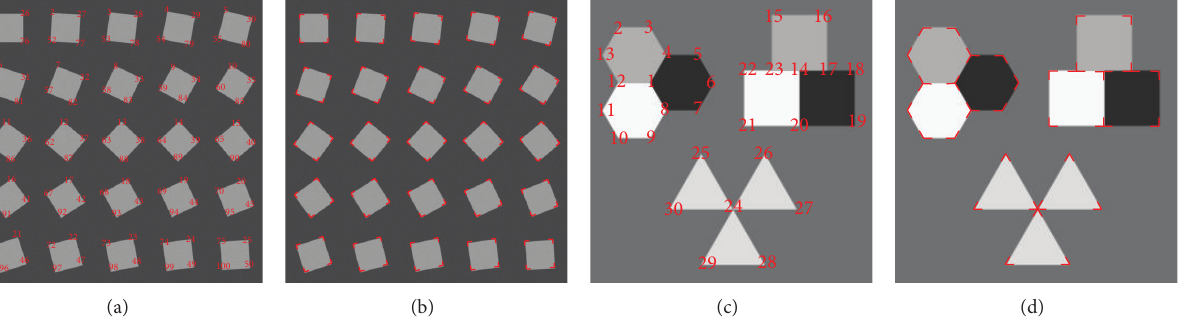
Figure 2: The results of junction points and junction branches detection for two images: quadrate image and polygon image. (a) Quadrate image. (b) The junction detection result of our proposed method. (c) Polygon image. (d) The junction detection result of our proposed method.